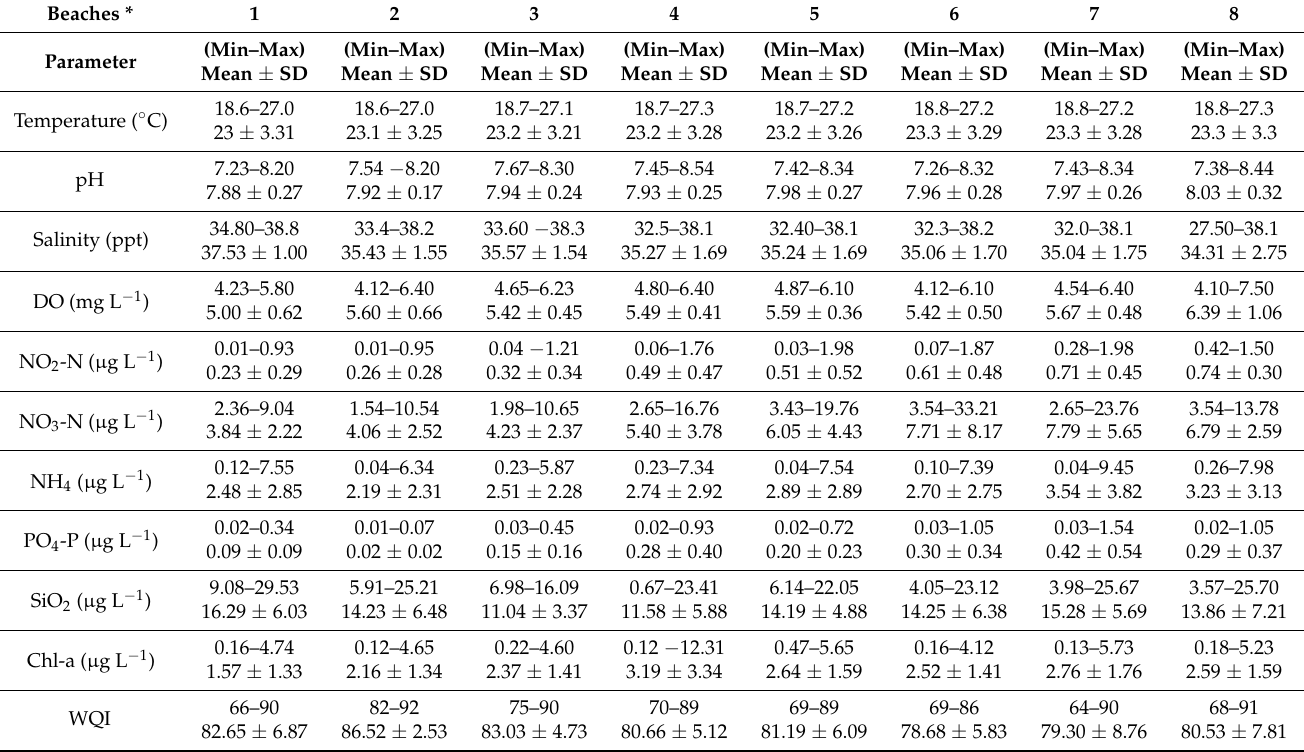
Table 2. The average monthly physicochemical parameters and standard deviation (SD) from March 2019 to February 2020 at the beaches in